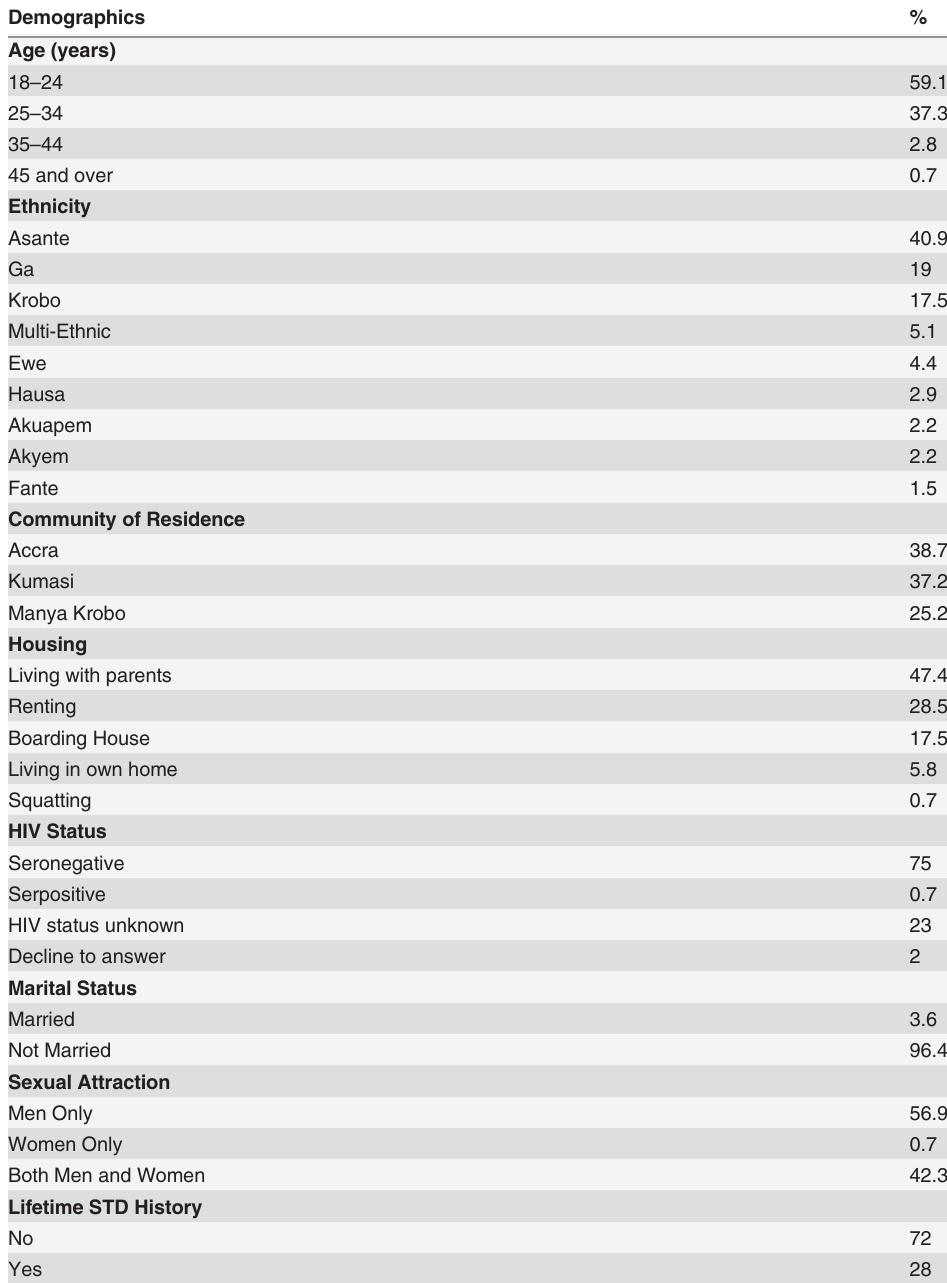
Table 2. Descriptive Statistics for Demographic Variables (N =